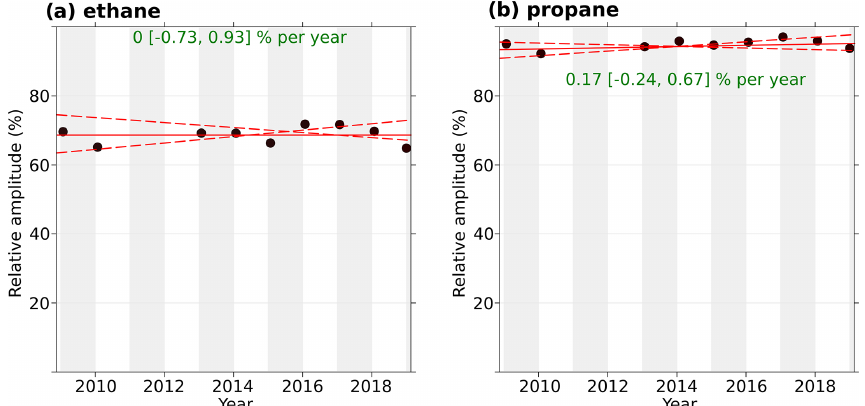
Figure 3. Trend in peak-to-peak seasonal amplitude of (a) ethane and (b) propane at GEOSummit, calculated as the relative difference between the maximum and minimum values from the smooth curve for each annual cycle. The solid red line shows the trend estimate, and the dashed red lines show the 95% confidence interval for the trend based on resampling methods. The overall trend is shown at the top, along with the 95% confidence interval in the